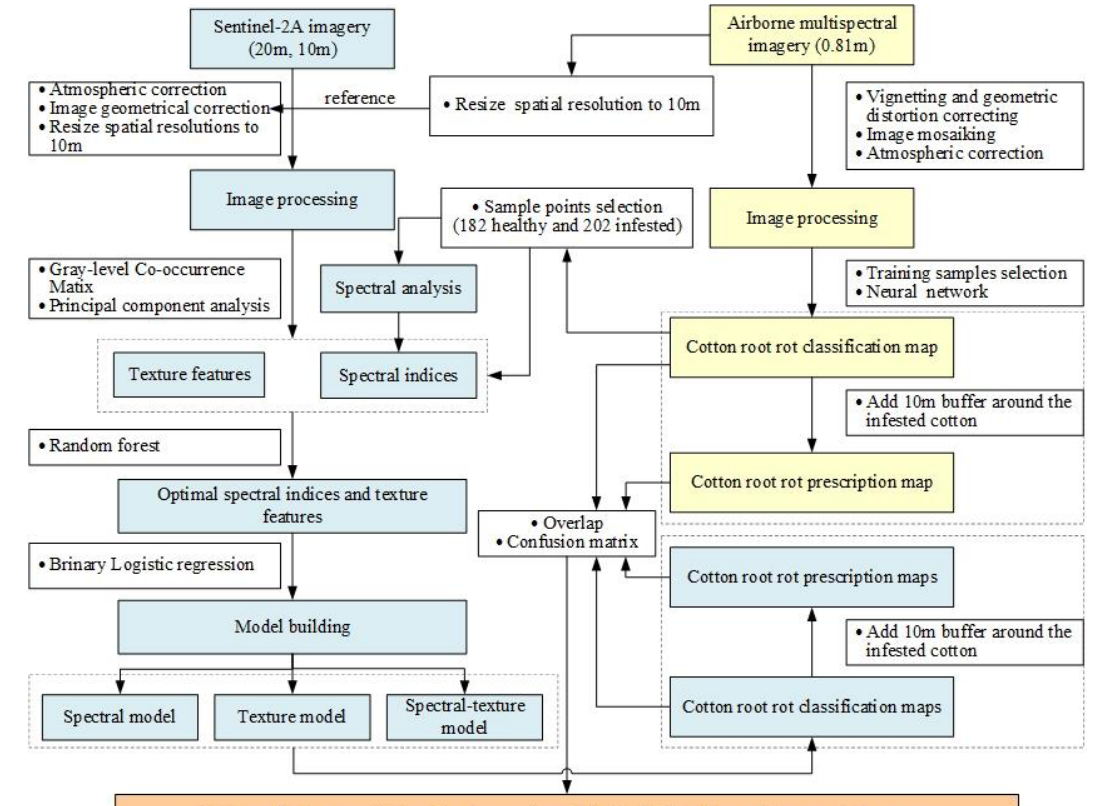
Figure 3. Flowchart of data analysis and processing.